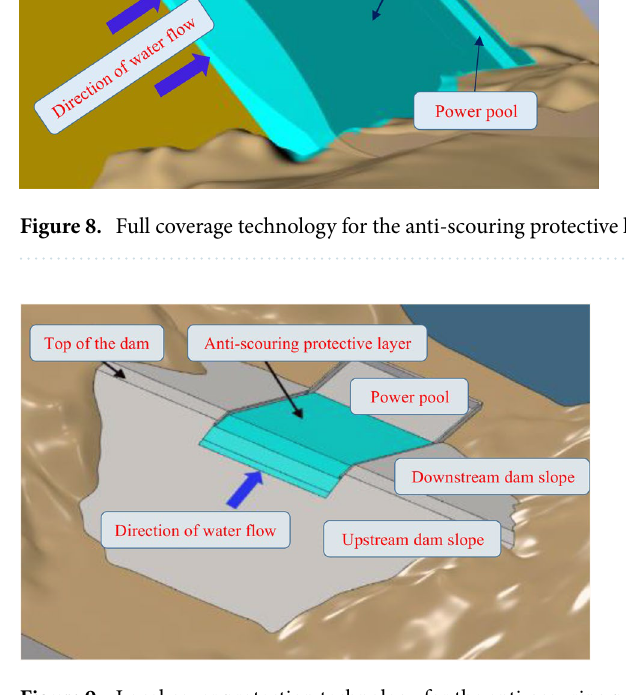
Figure 9. Local cover protection technology for the anti-scouring protective